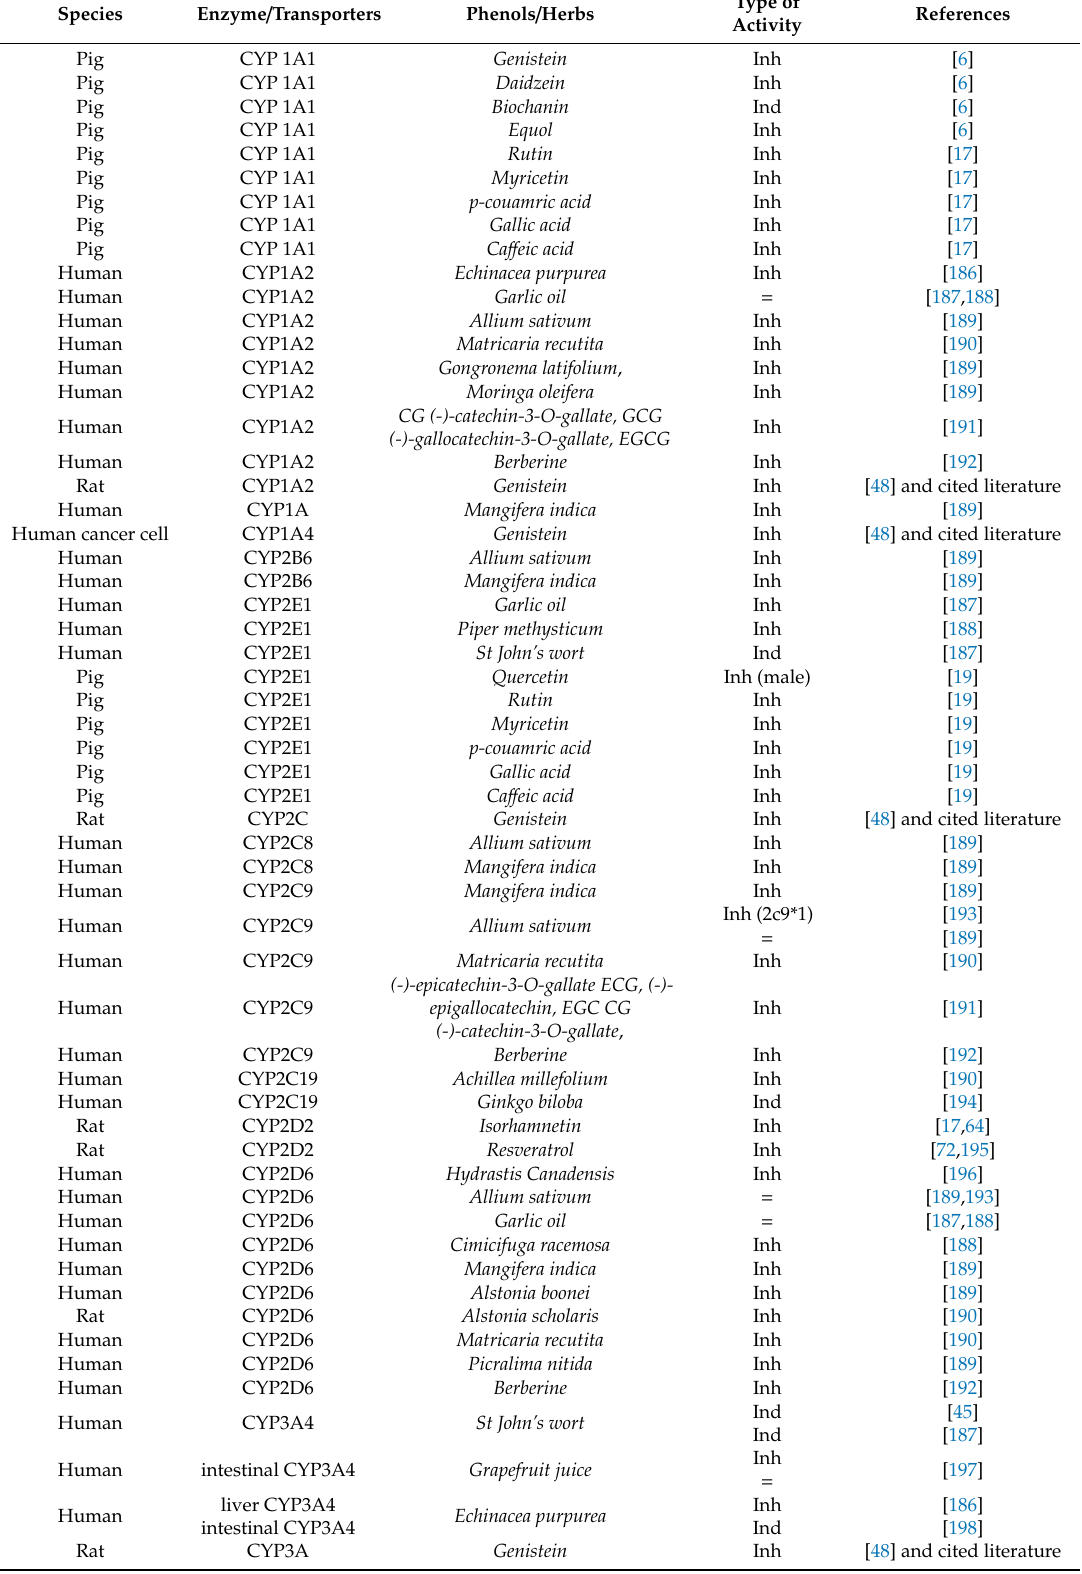
Table 2. Activity of some phenols and herbs on drug metabolic enzymes and transporters.